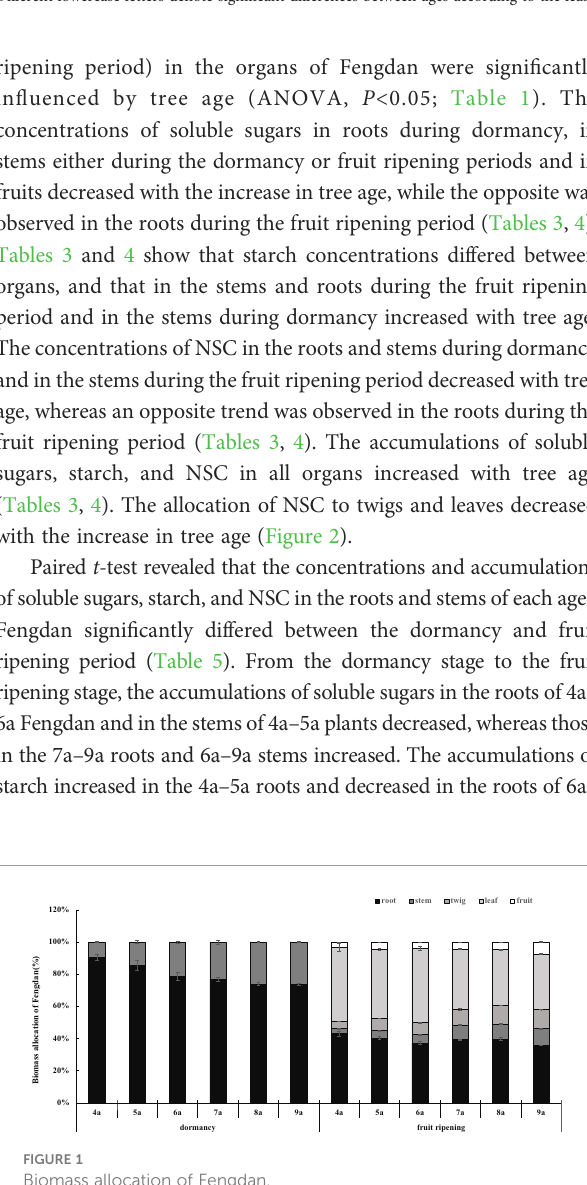
FIGURE 1 Biomass allocation of Fengdan.